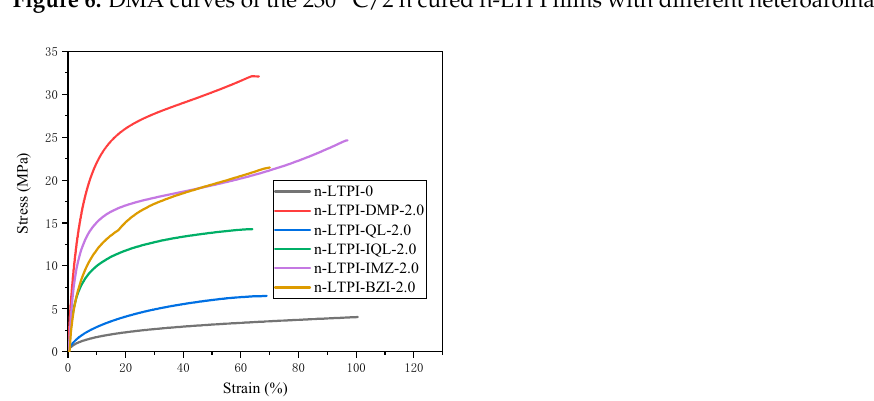
Figure 6. DMA curves of the 230 °C/2 h cured n-LTPI films with different heteroaromatic bases.